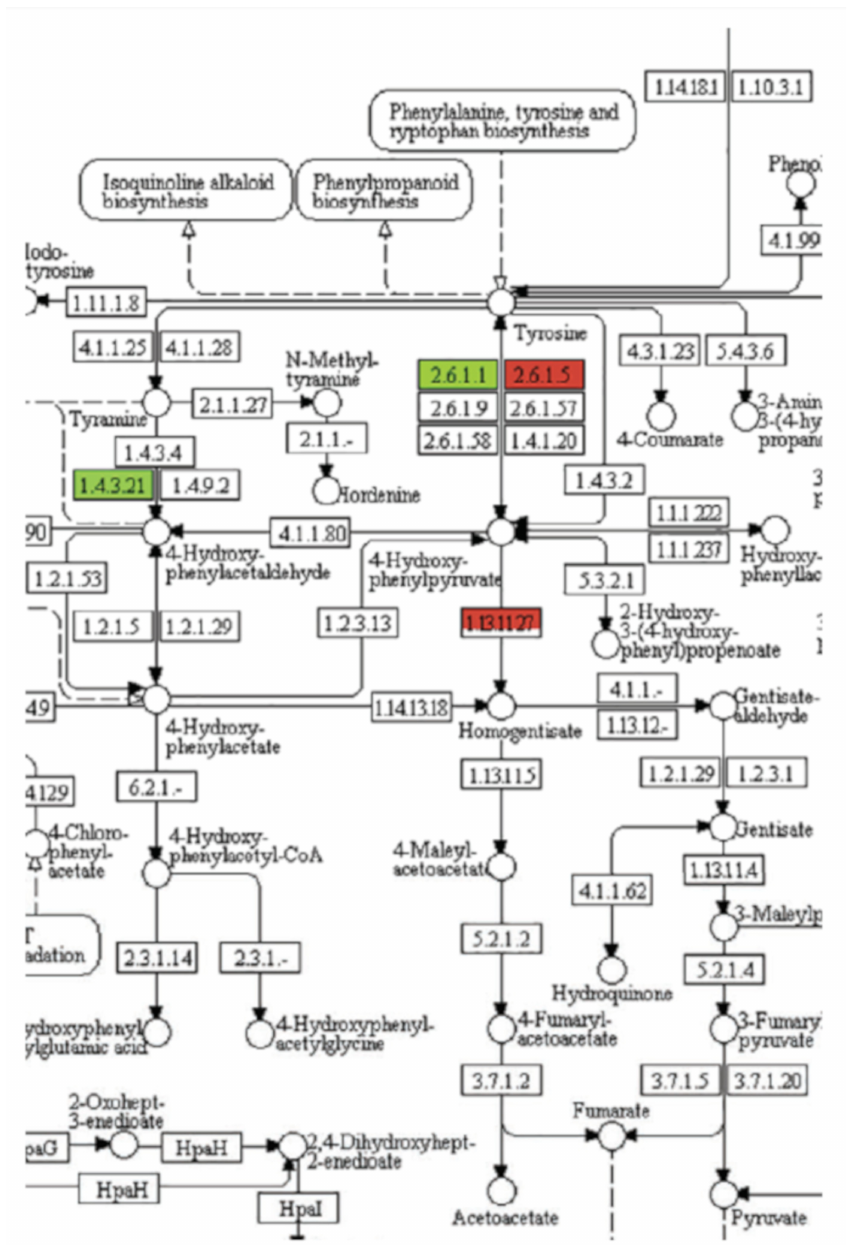
Figure 5. Example of Kyoto Encyclopedia of Genes and Genomes (KEGG) analysis of the e ff ects of t -chalcone on transcription of genes of tyrosine metabolism of Arabidopsis roots 1 h after exposure. The level of color saturation of green and red represents the level of down- and upregulation, respectively. This is a portion of a more detailed figure from